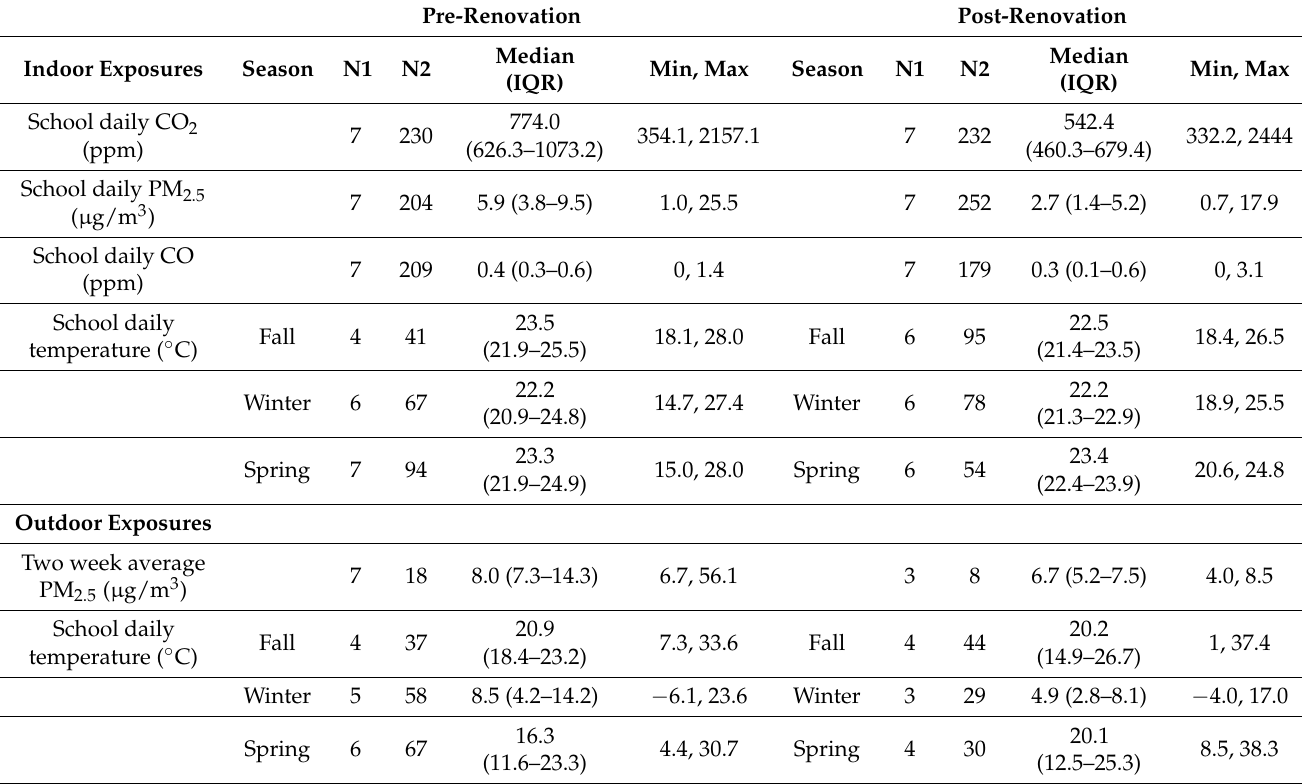
Table 2. Characteristics of indoor and outdoor air quality and performance outcomes by renovation status in 7 schools with pre- and post-renovation